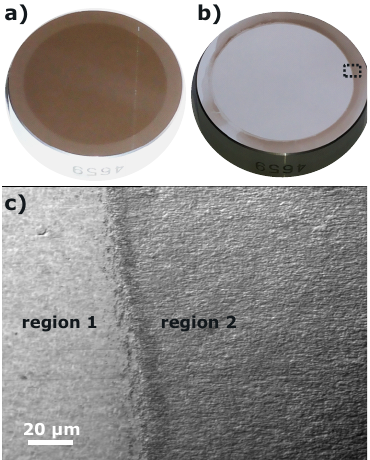
Figure 3. a) Aluminium sample after nitrogen ion beam treat- ment (1.5keV) applying a graphite contact mask with 38mm opening. b) The nitride layer was removed by wet-chemical pro- cessing with a 1% KOH solution. c) Microscopy image of the marked area in b). Region 1 defines the sample area, which was first ion beam treated and subsequently wet-chemically etched. Region 2 indicates the area, which was masked during ion beam treatment and thus only wet-chemically